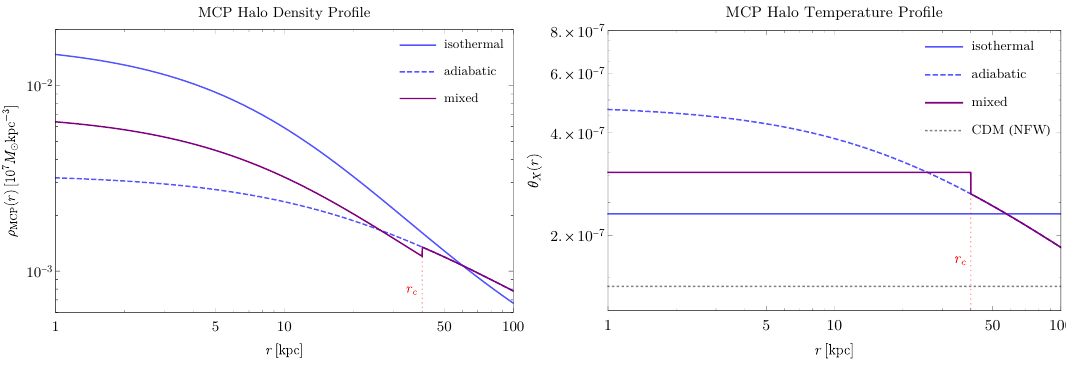
Figure 4 . The mass-density ρ MCP (left) and the temperature θ X (right) profiles of the MCP of the fully-isothermal, fully-adiabatic and “mixed” halos. We assume r c = 40 kpc for the “mixed” halo. calculation to within less than 50% error, which corresponds to the right of the dashed purple lines in figure 6. We note that this crossover regime coincides with the regime where cooling becomes important (see in section 4.3), and so requires a full analysis of both effects which is left to a future study. We will therefore treat the halo as isothermal in our parameter